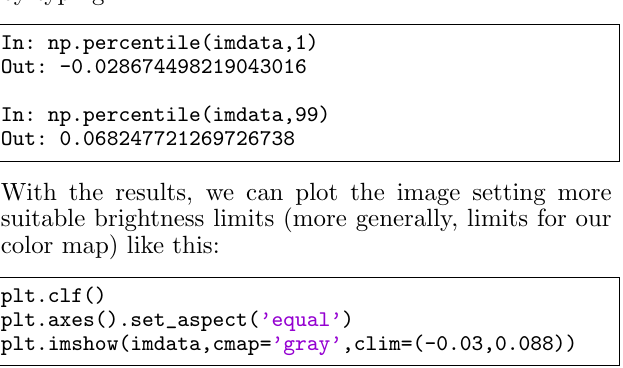
the pixels fall). We can access those descriptive numbers by typing